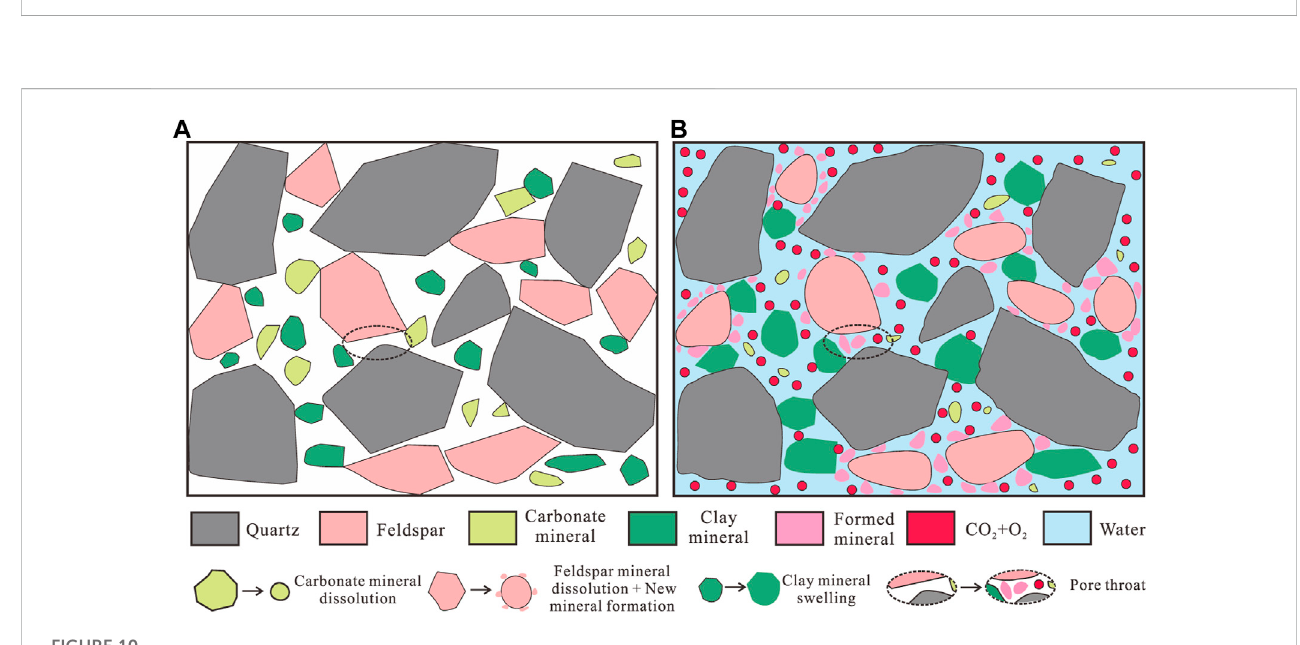
FIGURE 10 Schematic diagram of the CO 2 + O 2 – water – rock geochemical reaction and its in fl uence on the pore structure. (A) Before the CO 2 + O 2 – water – rock geochemical reaction; (B) after CO 2 + O 2 – water – rock geochemical